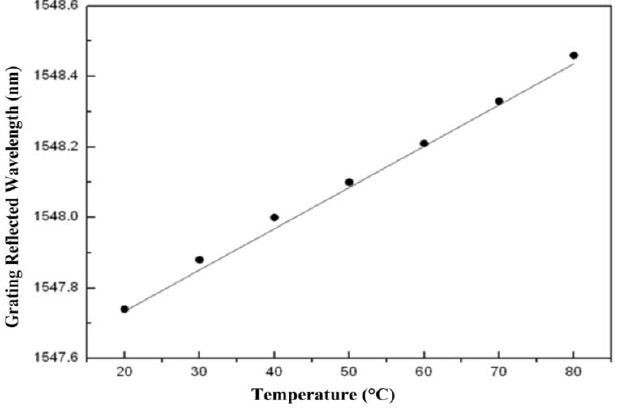
Figure 4. Changes in the center wavelength of FBG at differing temperatures.